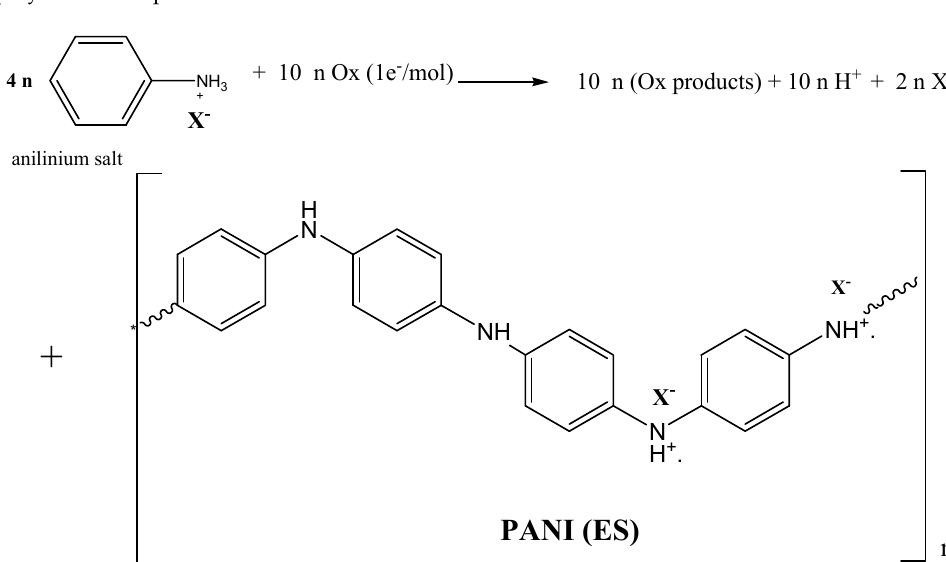
Figure 2. Evolution of temperature during grinding in a mortar and the effect of humidity on the polymerization process.